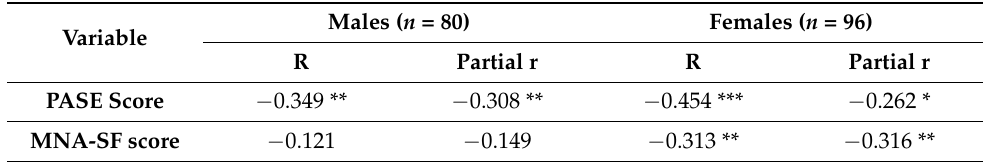
Table 2. Pearson’s (r) and partial r † correlation coefficients of PASE score and MNA-SF score with TUG time for males and females ( n =